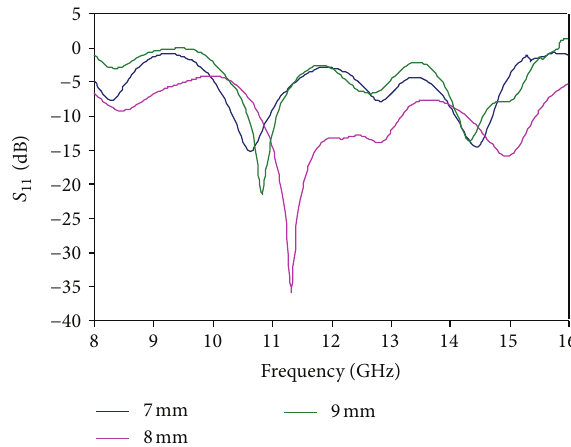
Figure 6: Reflection coefficient with different values of 𝑊 5 .